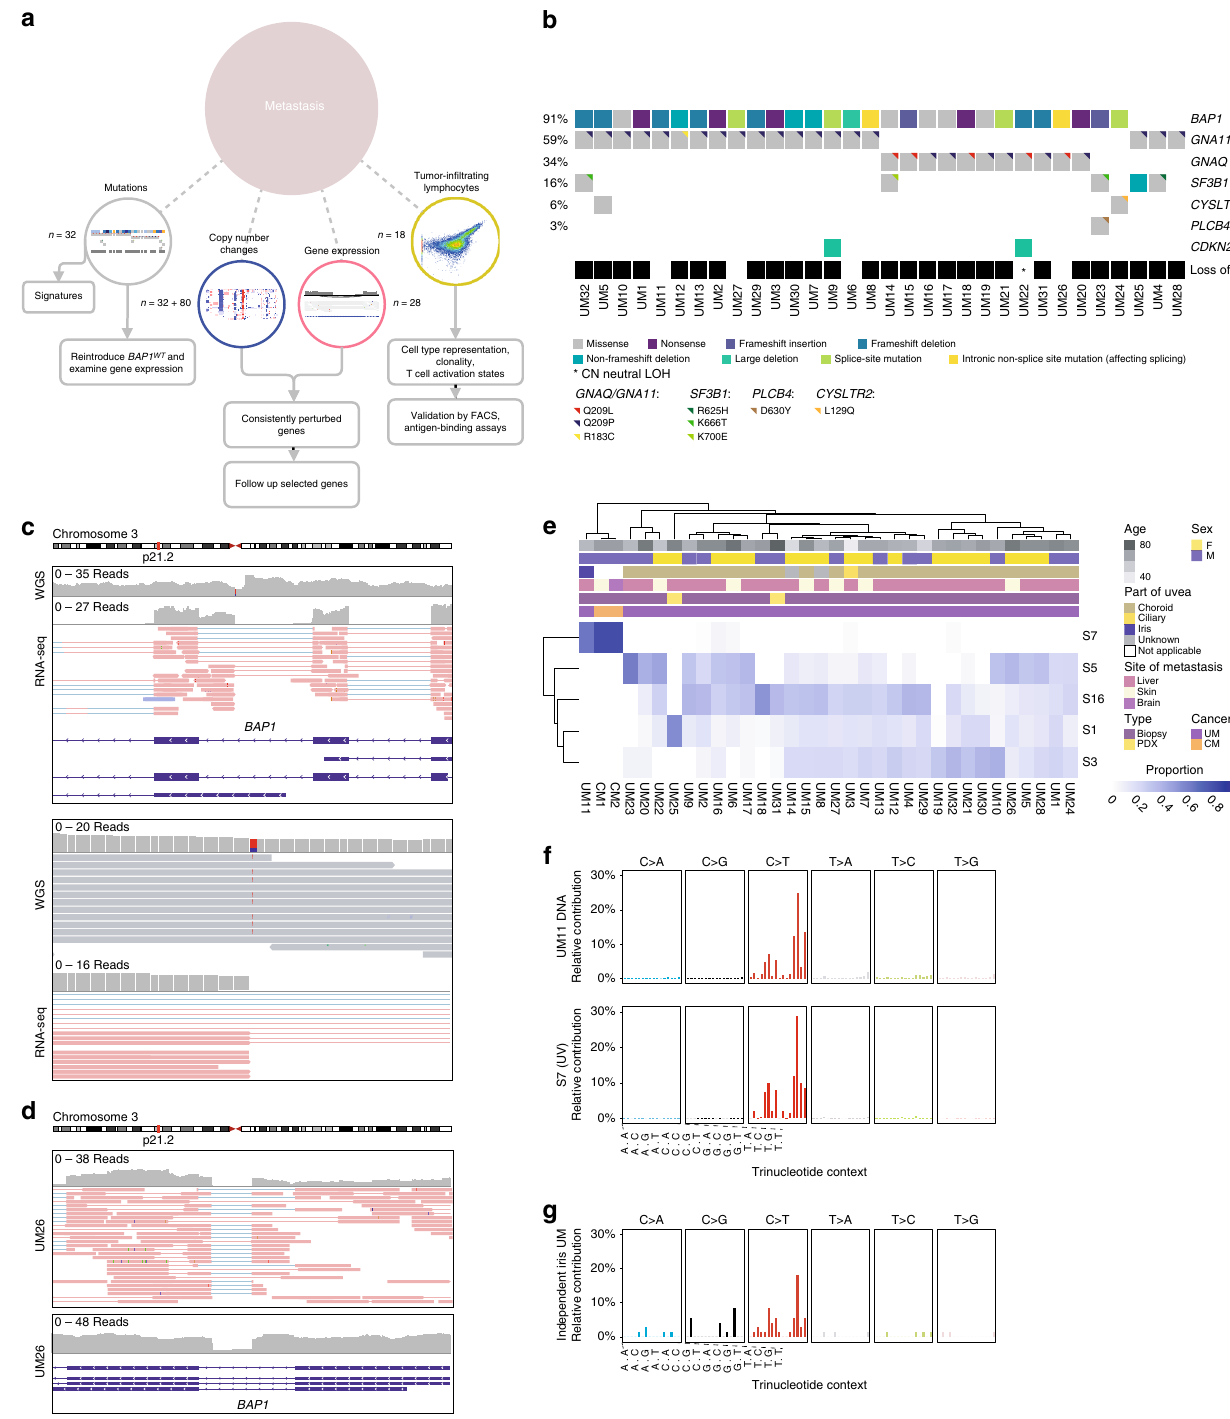
Fig. 1 Mutations in metastatic uveal melanoma (UM). a Overview schematic of the study. Thirty-two samples were subjected to whole-genome sequencing and 28 to RNA sequencing. Eighty tumors from TCGA were compared in copy number analyses. TILs from 15 tumors were used for antigen- reactivity assays and 5 of these, as well as 3 other tumors were used for single-cell analyses of TIL phenotypes. b Mutations in genes recurrently altered in UM. Chromosome 3 status is indicated. c Intronic non-splice site point mutation in BAP1 , associated with aberrant splicing. d Intronic large deletion in BAP1 associated with aberrant splicing. e Estimated contributions of COSMIC mutational signatures. Samples and signatures are ordered by agglomerative hierarchical clustering. Signatures with estimated contribution <30% excluded. n = 32 independent UM samples were included and n = 2 cutaneous melanomas (representing two metastases from one patient) sequenced at the same time were included for comparison. Signatures were inferred using both synonymous and non-synonymous mutations. CM: cutaneous melanoma. f Overall mutational spectrum of UM11, based on WGS data. The canonical pro fi le of the UV-associated “ signature 7 ” is shown for comparison. g Mutational spectrum from exome data of an unrelated primary iris